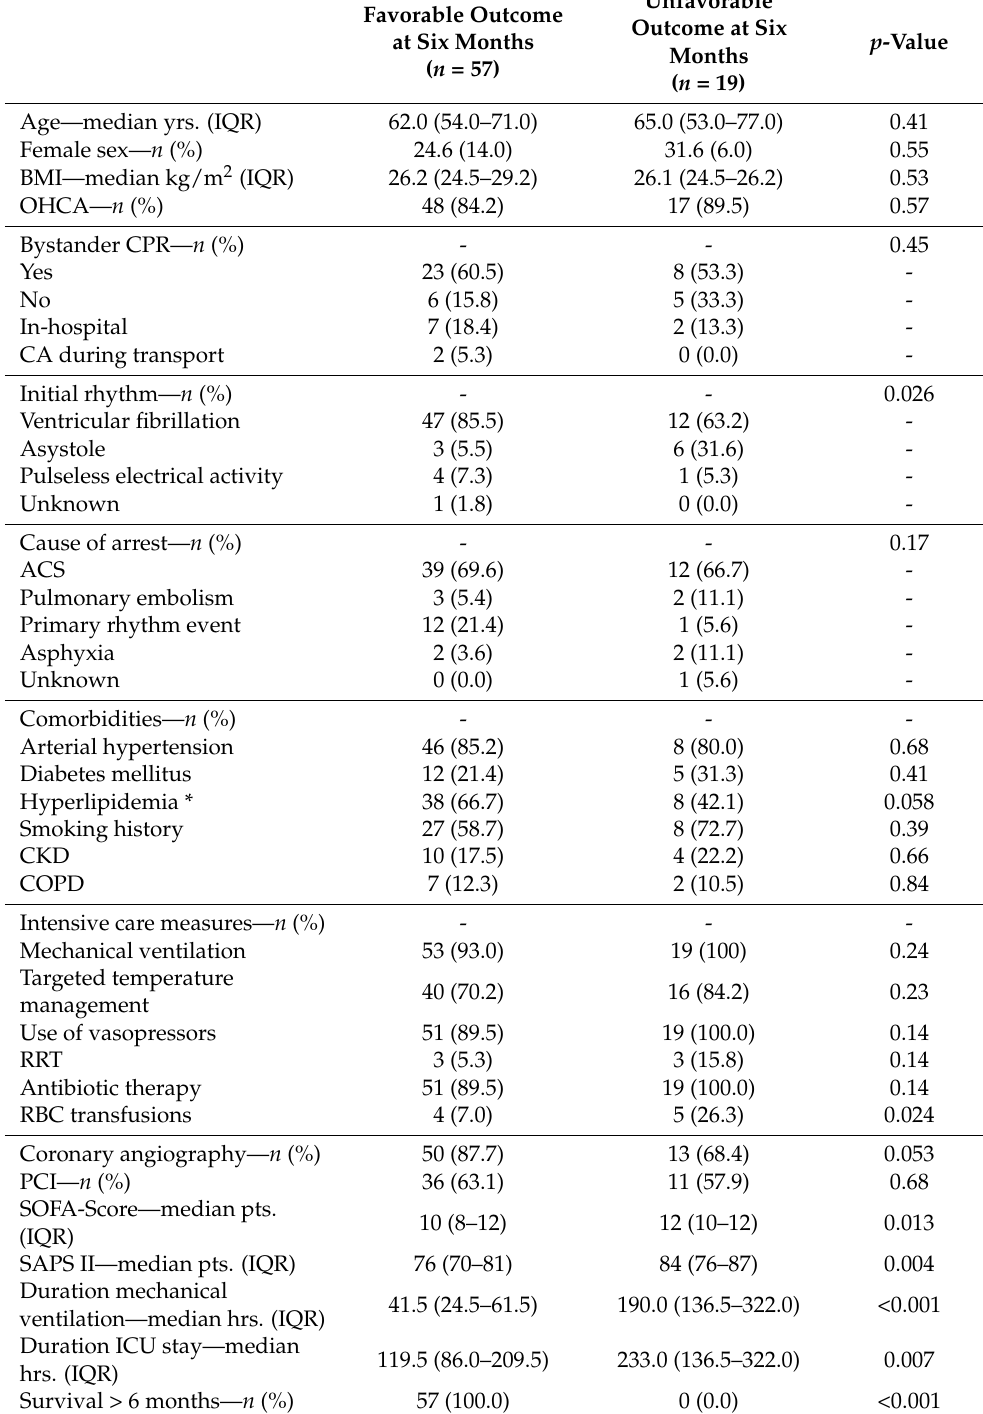
Table 1. Baseline characteristics, CPR-specific data, intensive care measures, and outcome data in patients with favorable vs. unfavorable outcome (death or CPC ≥ 3 after six